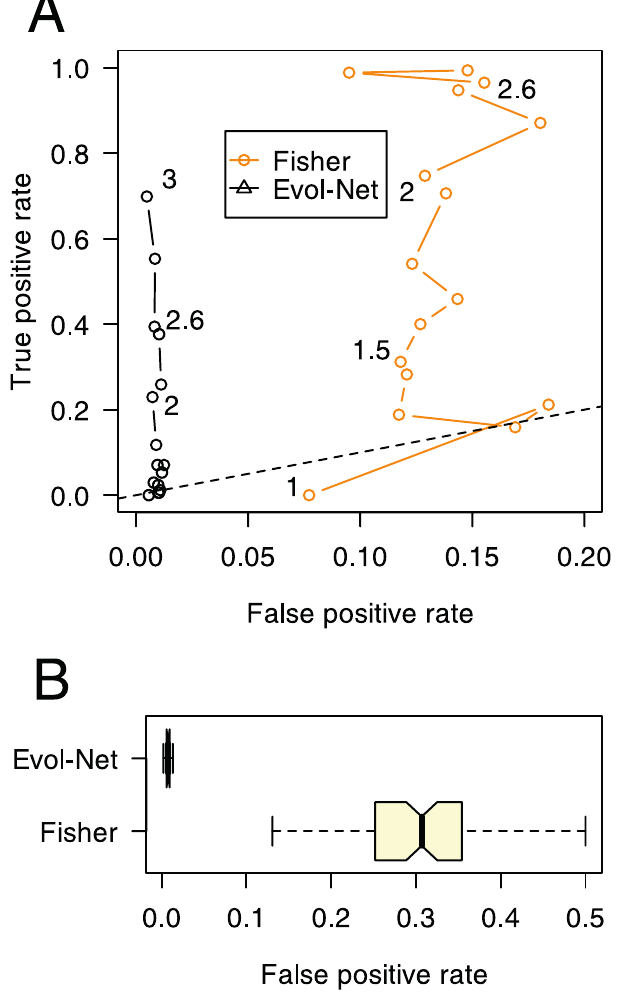
Figure 1. True- and False-Positive Rates on Simulated Data (A) A receiver operating characteristic (ROC)-like curve, in which the y - axis corresponds to the true-positive rate (TPR), and the x -axis corresponds to the false-positive rate (FPR). A perfect analytical method would be located in the upper-left corner (i.e., TPR ¼ 1, FPR ¼ 0), whereas methods located near the diagonal (dashed line, TPR ¼ FPR) are statistically equivalent to a random guess. Each point in the plot corresponds to the mean outcome from the corresponding model analysis (orange ¼ the Fisher exact test, black ¼ evolutionary-network) of ten replicate simulations of binary-state sequences evolving under various settings of the pairwise coevolution parameter, e (ranging from 1 to 3; see figure labels). (B) Boxplots corresponding to the false-positive rate (as a fraction of the total number of pairwise comparisons ¼ 528) from the corresponding analysis (evolutionary-network [Evol-Net] or Fisher exact test [Fisher]) of simulated sequences evolving according to a null model of codon substitutions in which sites evolve independently, using parameter settings estimated from the original V3 sequence alignment. We generated 100 replicate simulations of nucleotide sequences evolving along the original neighbor-joining tree.